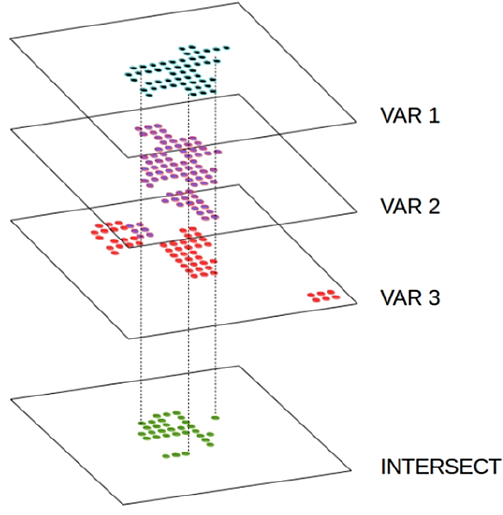
Figure 2. Example of intersection among three